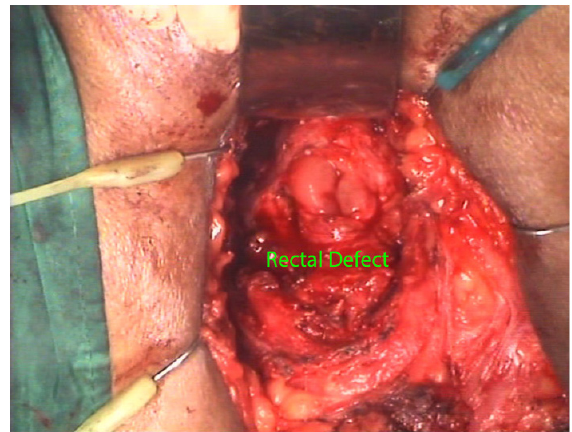
Figure 3. Rectal wall defect at the level of